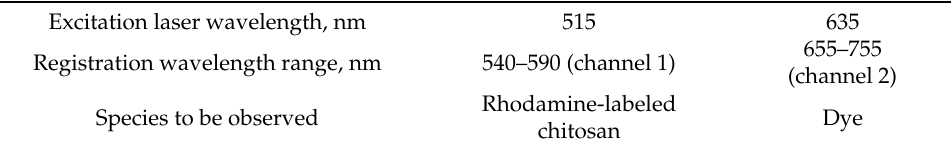
Table 3. Modes of confocal laser scanning microscope measurements.